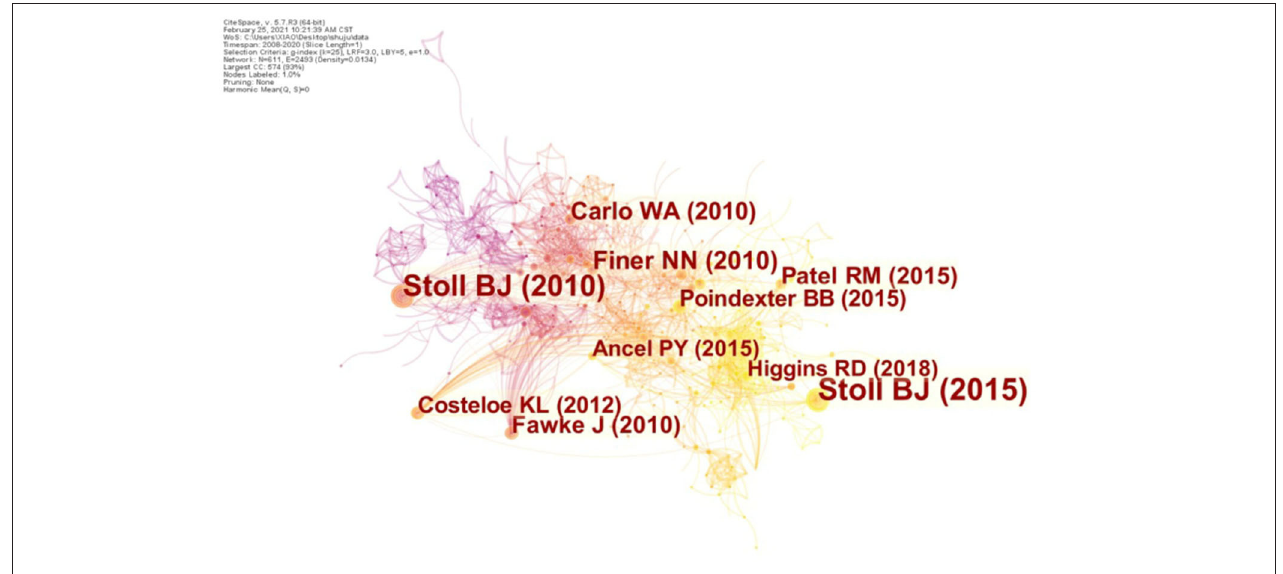
FIGURE 4 | Top 10 highly cited articles on BPD in extremely pre-mature infants.